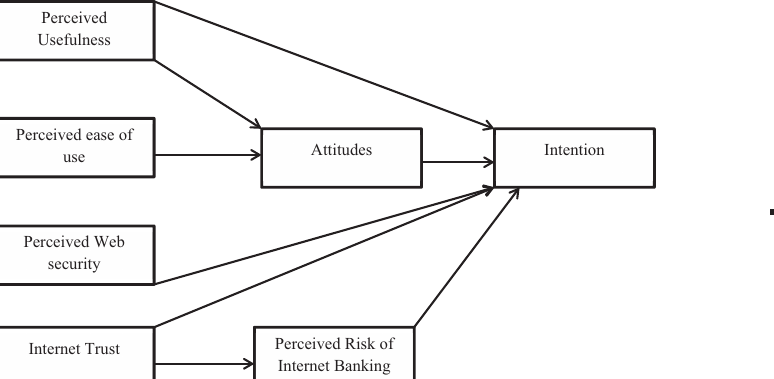
Figure 1. Research framework